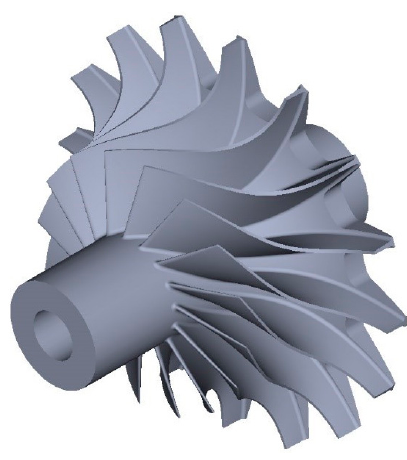
( b ) Tip clearance mesh closeup Figure 10. Computational mesh of the T-100.